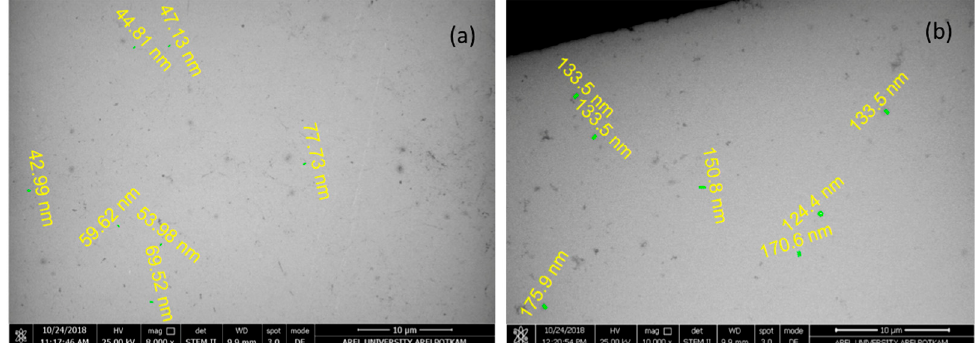
Figure 9. ( a ) Nano-propolis-10 (NP-10; 840 mg/350 mL) ( b ) Nano-propolis-30 (NP-30; 1260 mg/180 mL).